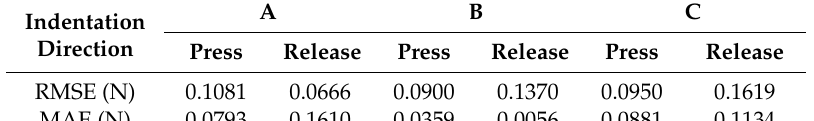
Figure 9. Real and mixed reality views of indentations A , B , C . Table 2. Error between measured and simulated forces for indentations A , B , C .